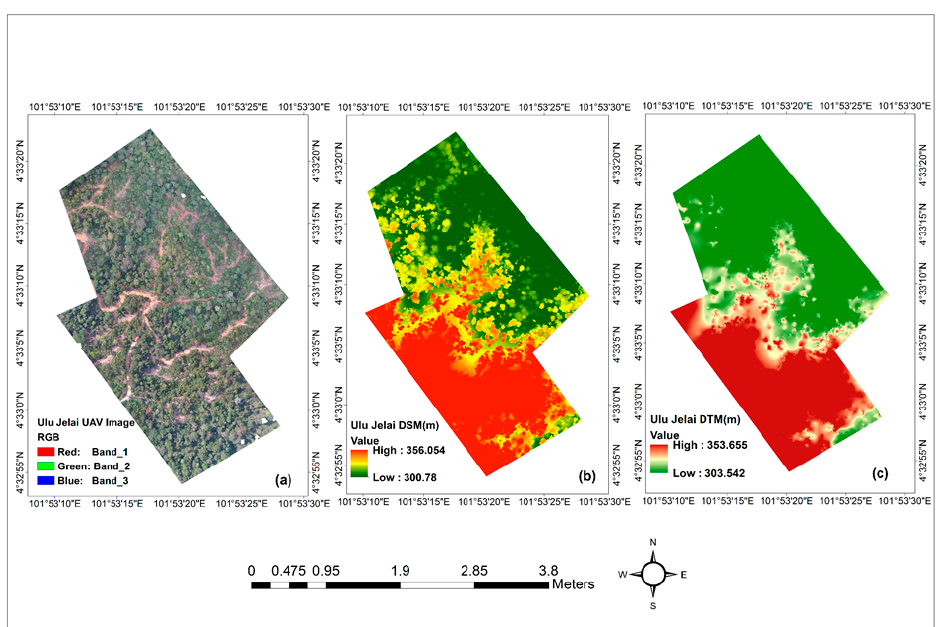
Figure 5. Types of data used in this study over Ulu Jelai forest reserve: ( a ) Very high-resolution image of UAV red green blue (RGB); ( b ) digital surface model (DSM); and ( c ) digital terrain model (DTM) .